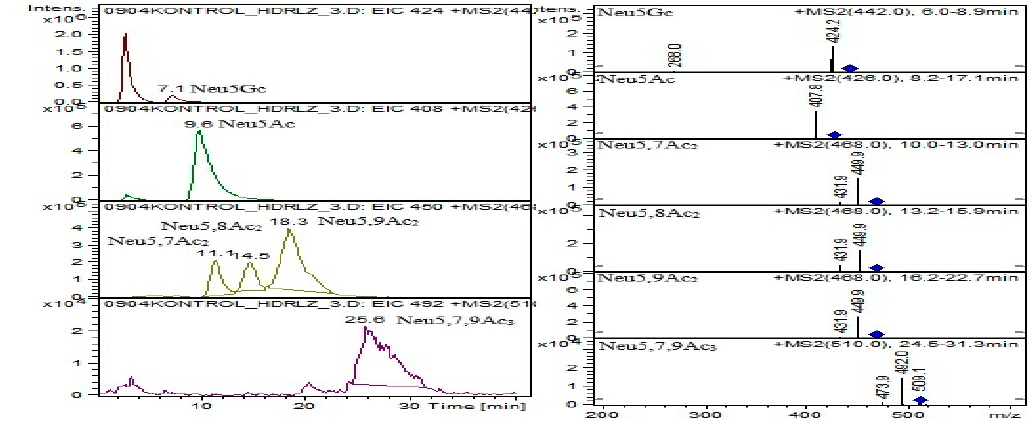
Figure 1. Six sia types and their